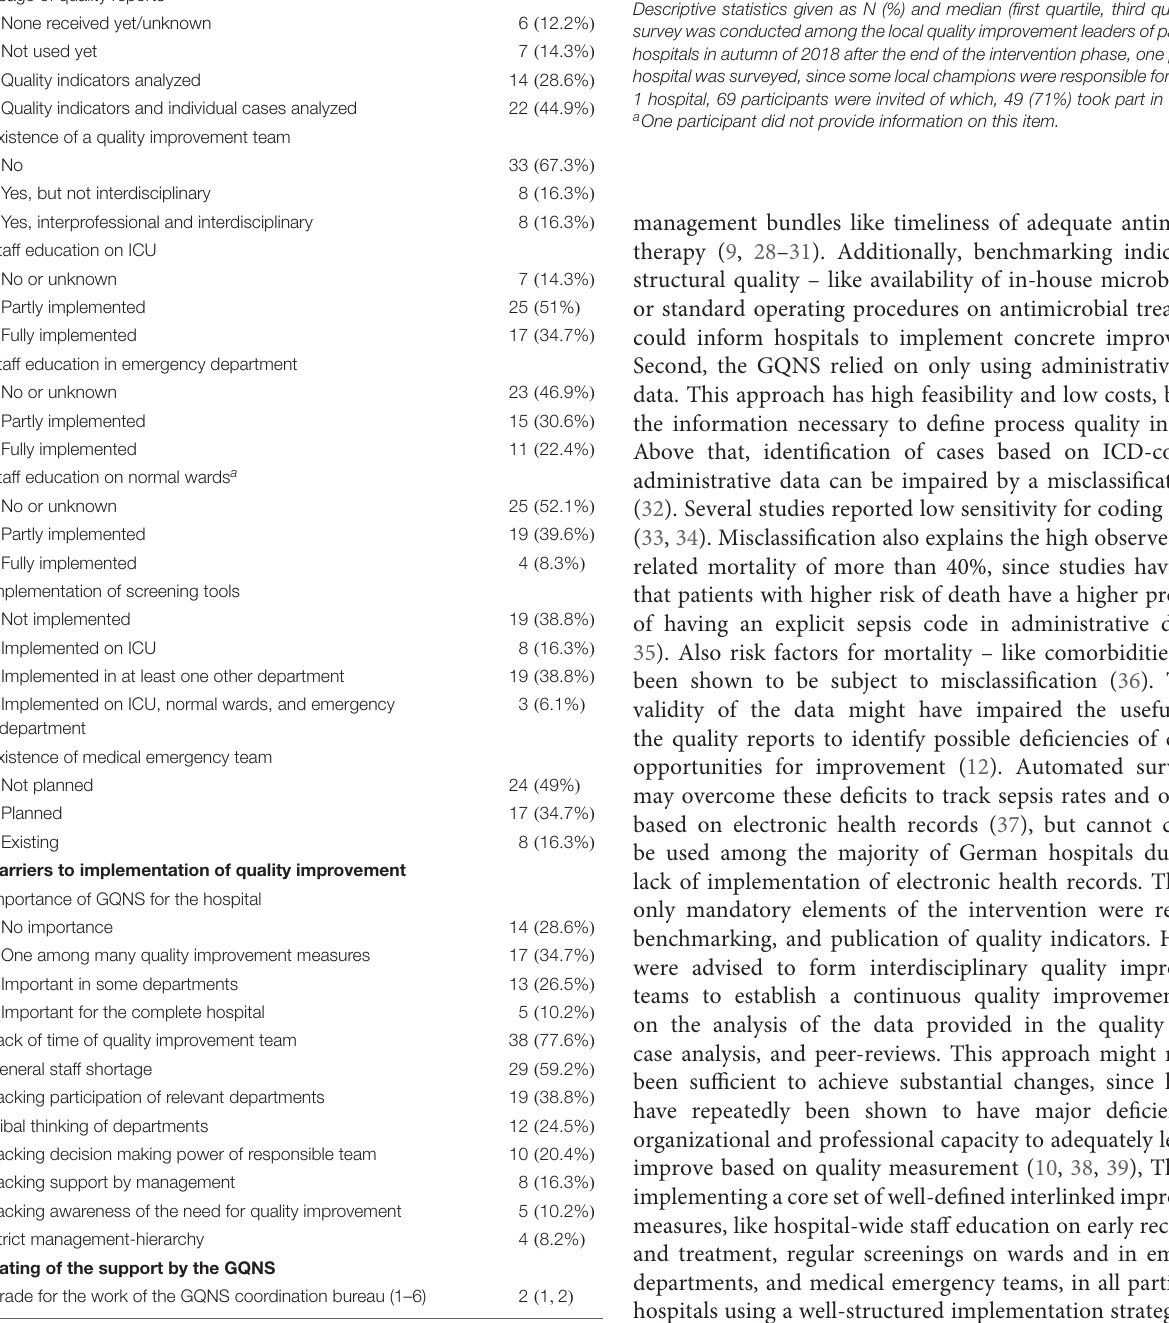
statistics for answers ( N = 49